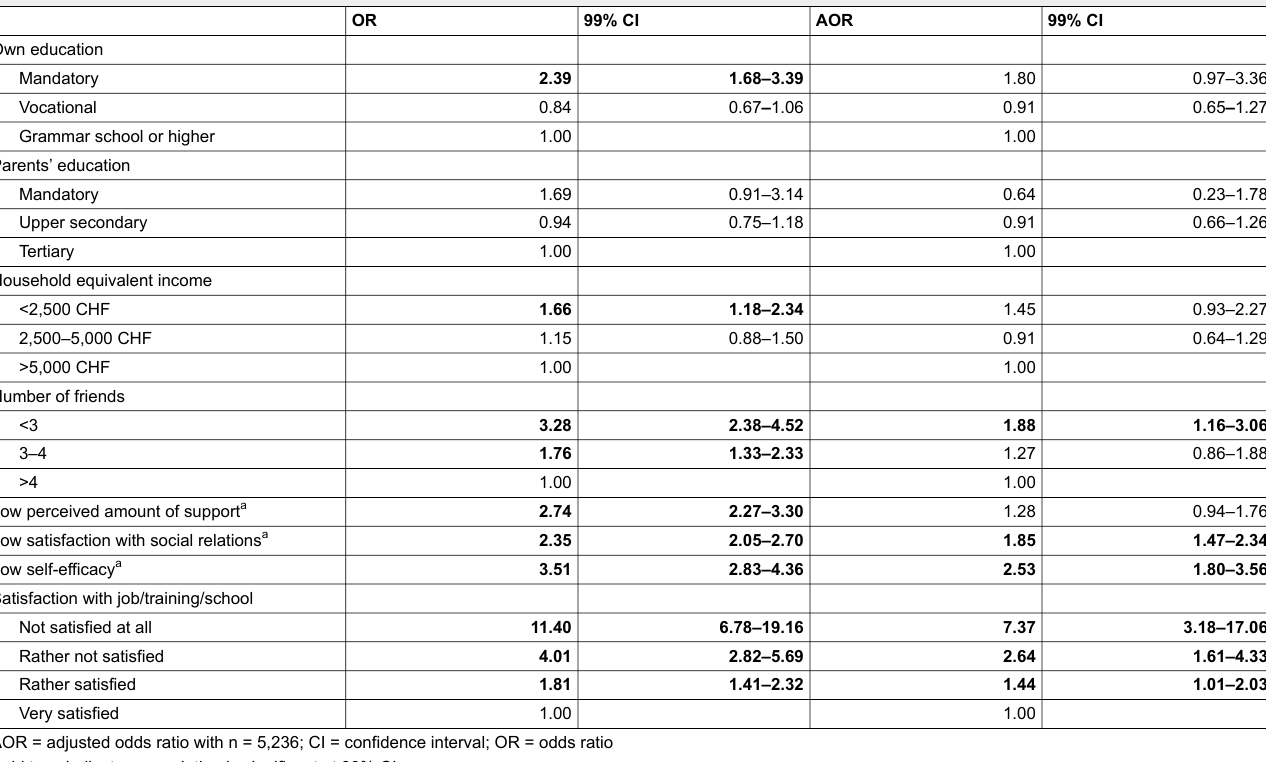
Table 3: Logistic parameter estimates for young men with full or subthreshold depression (n = 9,066). Estimates as unadjusted and adjusted odds ratios with 99% confidence intervals.